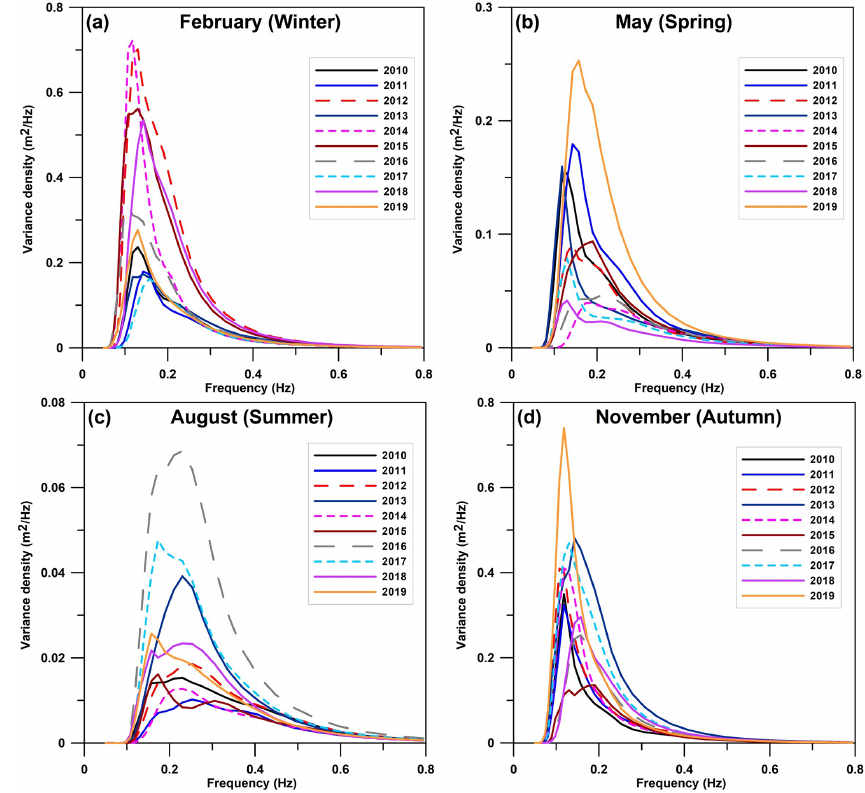
Figure 11. Simulated monthly mean wave spectra for the time slice 2010–2019 for (a) February (winter), (b) May (spring), (c) August (summer), and (d) November (autumn) at station 6 (Cesenatico; see Fig. 1c for location). Table 6. The best-fit Weibull scale and shape parameters for H s (columns 3–4) at the eight control points. Column 5 shows the estimated χ 2 values. Mean, variance, skewness, and kurtosis of H s (columns 6–9) computed from the model data (left sub-columns) and from the Weibull fit parameters (right sub-columns) and the wave height hazard index (with threshold value X c , H s = 1 . 08m) calculated with (Eq. 6) for the eight control points (indicated in the last column) along the Emilia-Romagna coastal